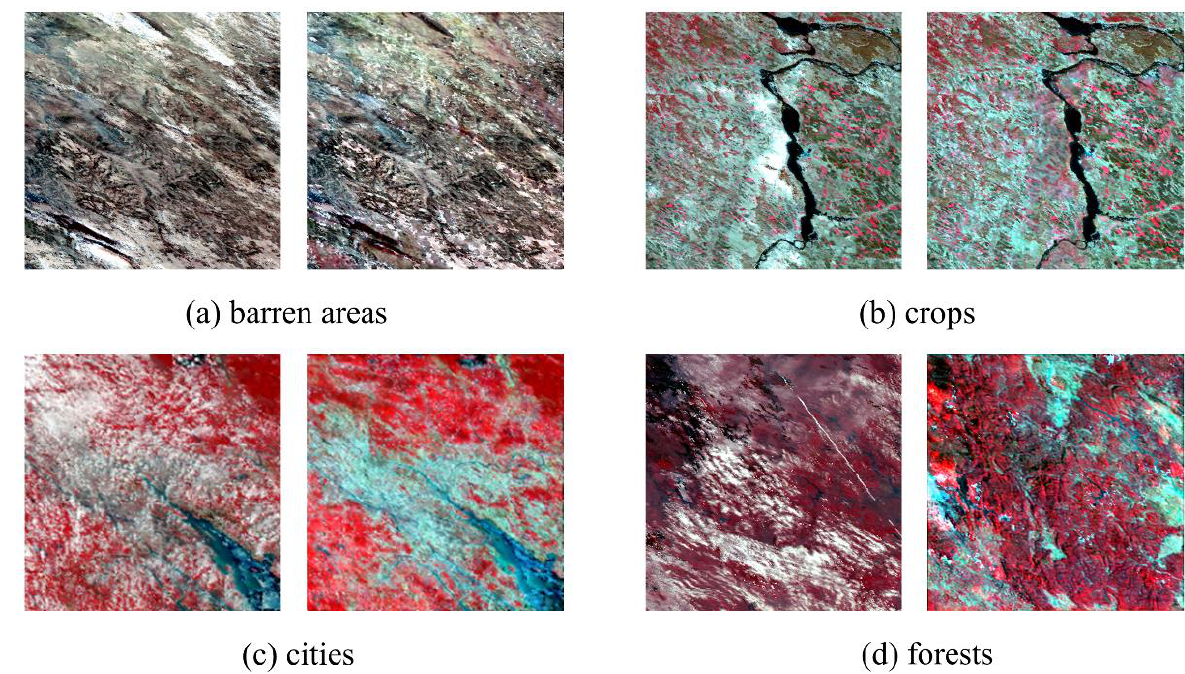
Figure 12. Reconstruction results of CSTG with different surface characteristics.